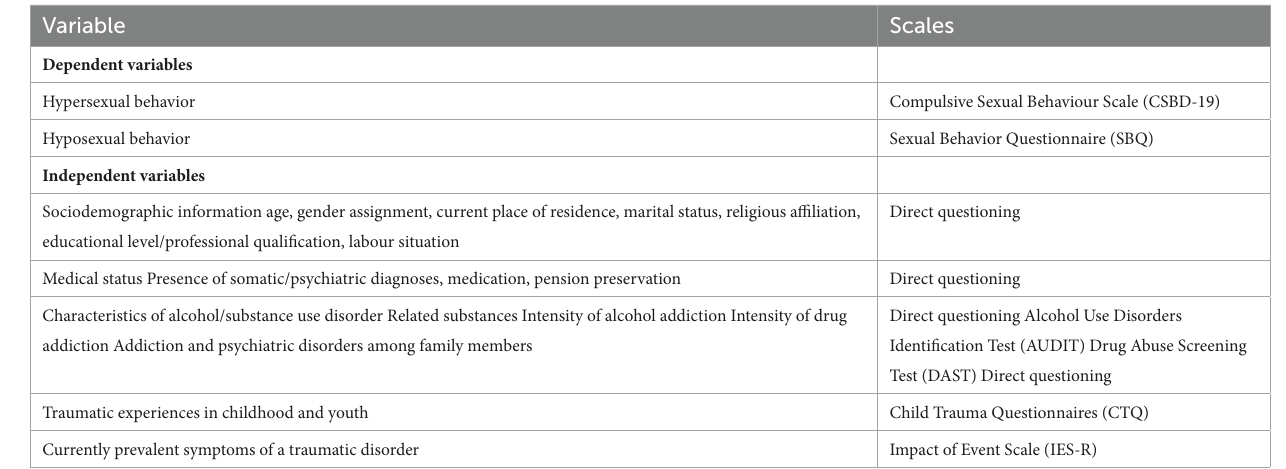
TABLE 2 Overview of dependent and independent